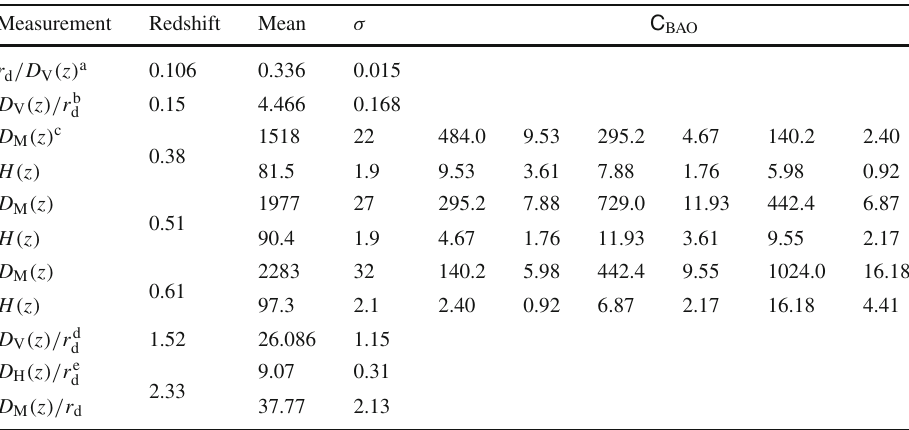
Table 1 BAO data